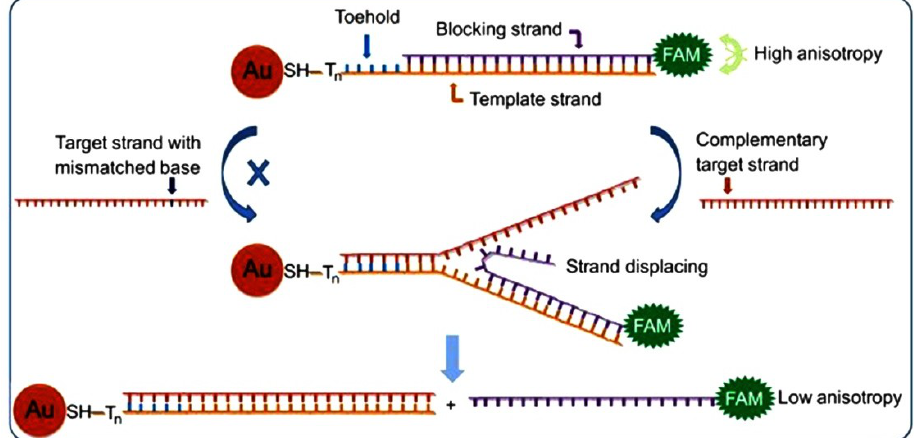
Figure 4. Schematic representation of toehold-mediated stand-displacement reaction based GNP enhanced fluorescence anisotropy for single nucleotide polymorphism (SNP) detection. Reprinted from reference [94], Copyright 2013, with permission from